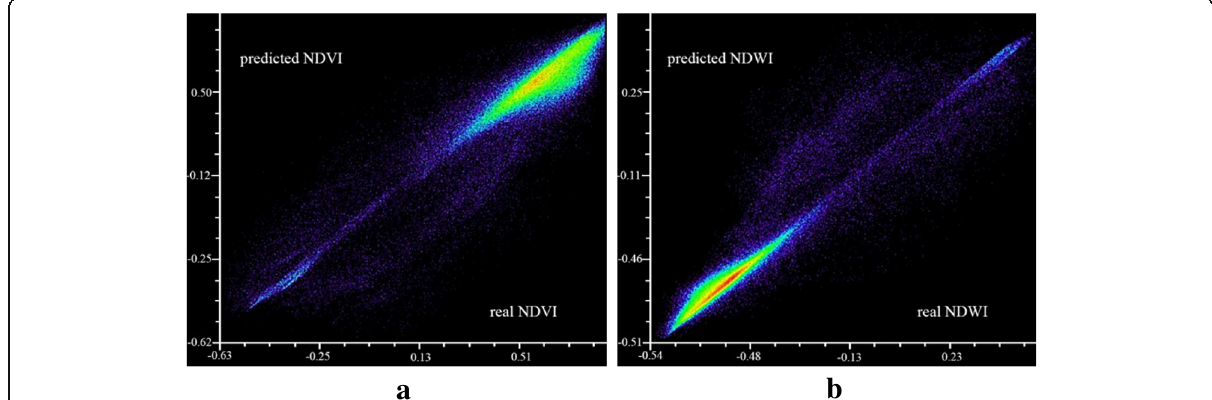
Fig. 3 The correlation analysis of fusion forecast data with NDVI and NDWI. a Correlation between real NDVI and predicted NDVI. b Correlation between real NDWI and predicted